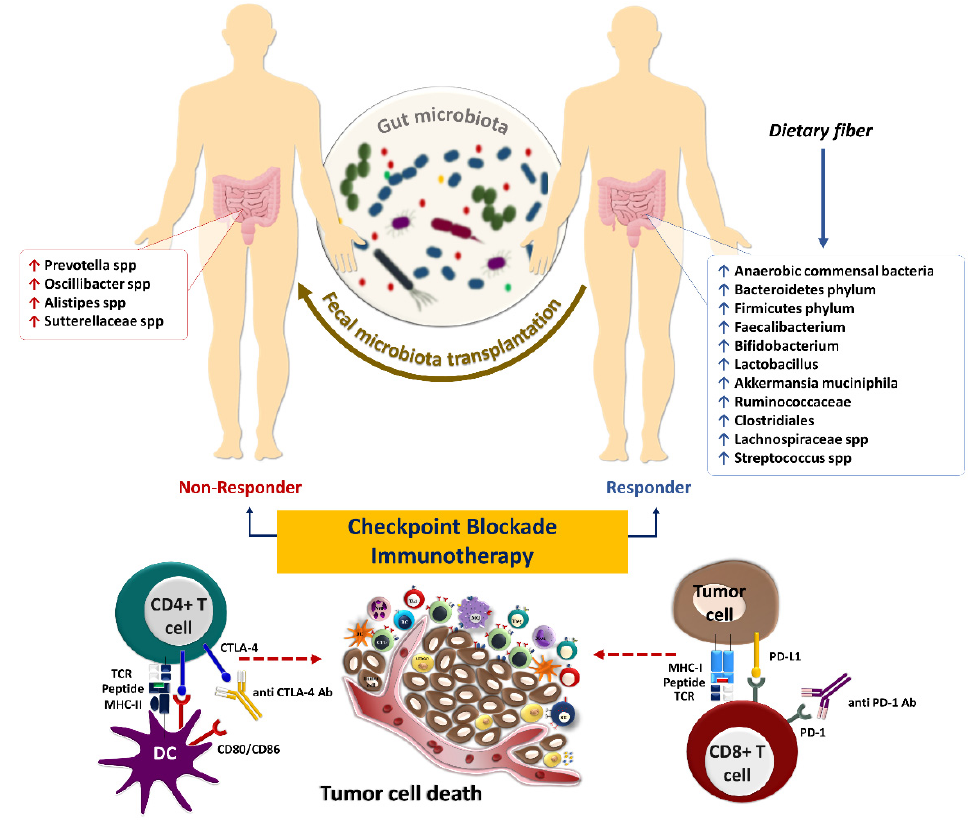
Figure 3. The influence of gut microbiota on the response to immune checkpoint inhibitors in cancer immunotherapy. Some microbes, including anaerobic commensal bacteria, which increase follow- ing sufficient dietary fiber intake, are associated with beneficial outcomes to checkpoint blockade immunotherapies such as anti-PD-1/PD-L1 and anti-CTLA4 antibodies [79]. Fecal microbiota trans- plantation could potentially improve the response in patients who failed to respond to such thera- pies.